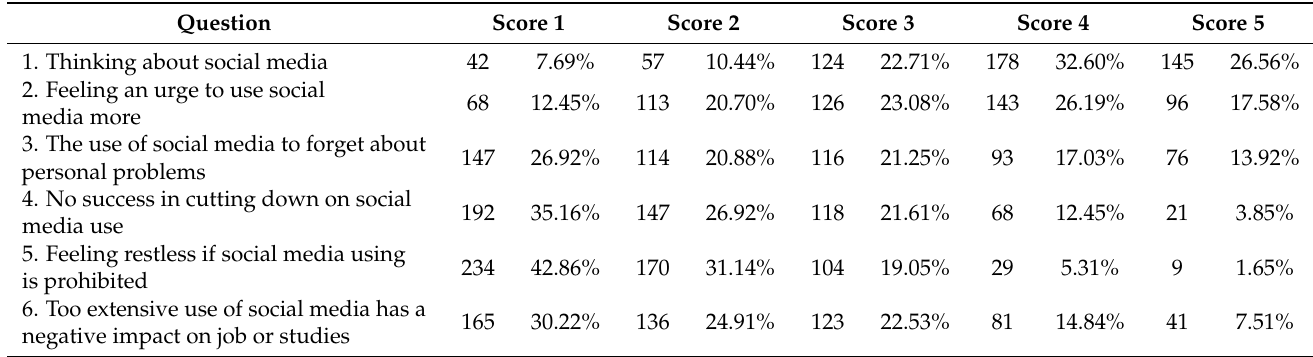
Table 2. Results of the Bergen Social Media Addiction